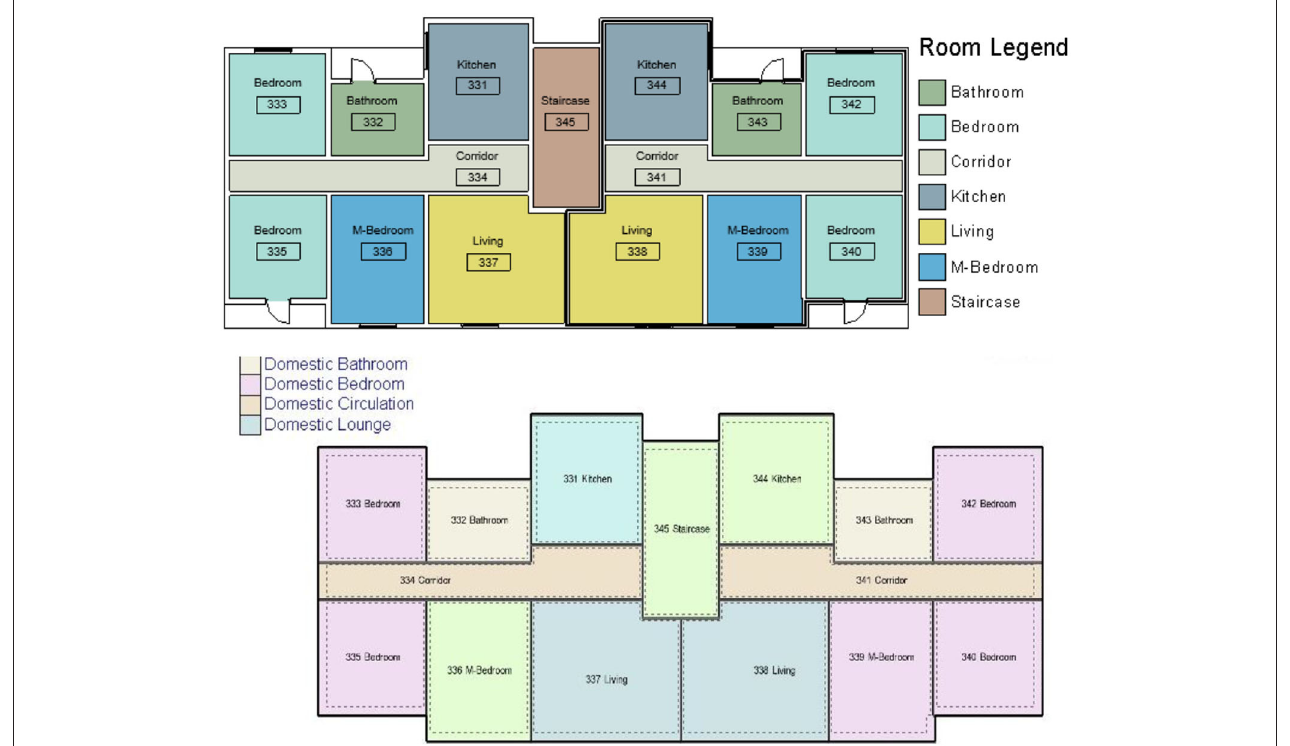
FIGURE 15 | Spaces and zones identification in Revit (left hand-side) and DesignBuilder (right